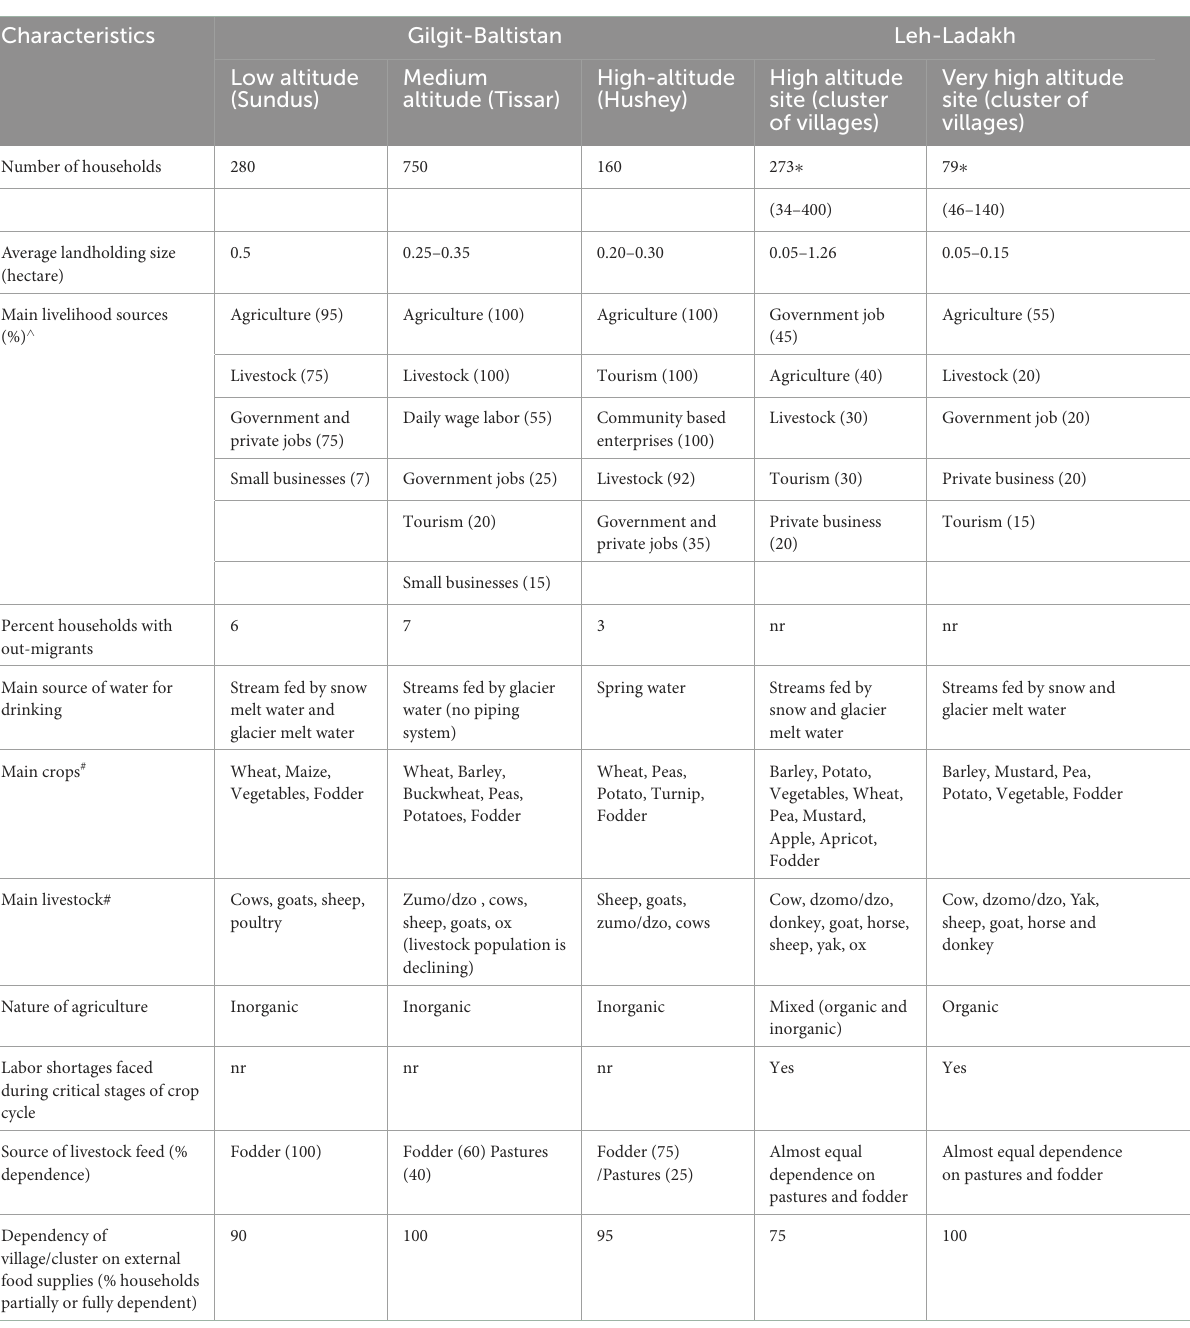
TABLE 2 Socio-economic characteristics and agriculture.